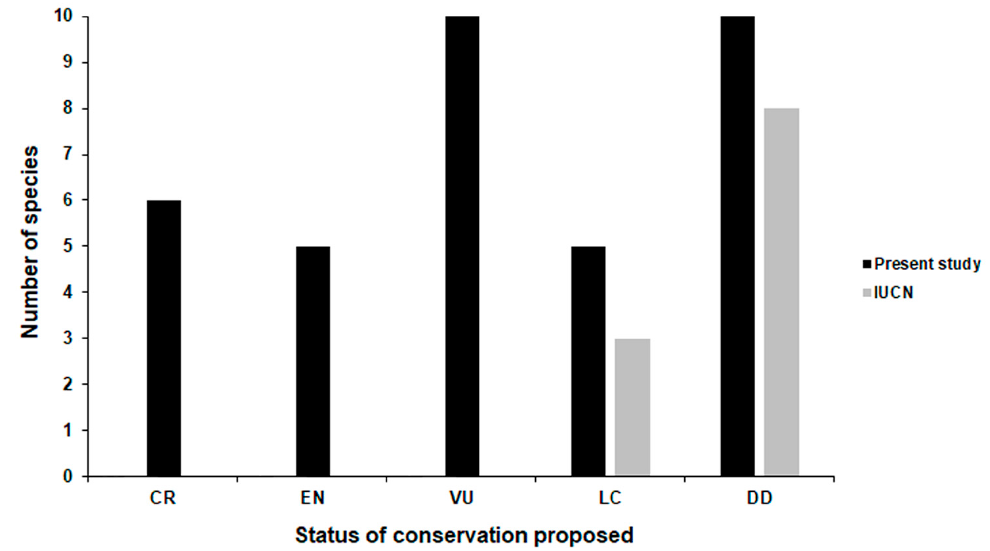
Figure 2. Status of conservation for the 36 species of Brachycephalus proposed in this study according to the IUCN [48] criteria and categories proposed by IUCN [31–41]. Abbreviation: CR = Critically Endangered; EN = Endangered; VU = Vulnerable; LC = Least Concern; DD = Data Deficient.